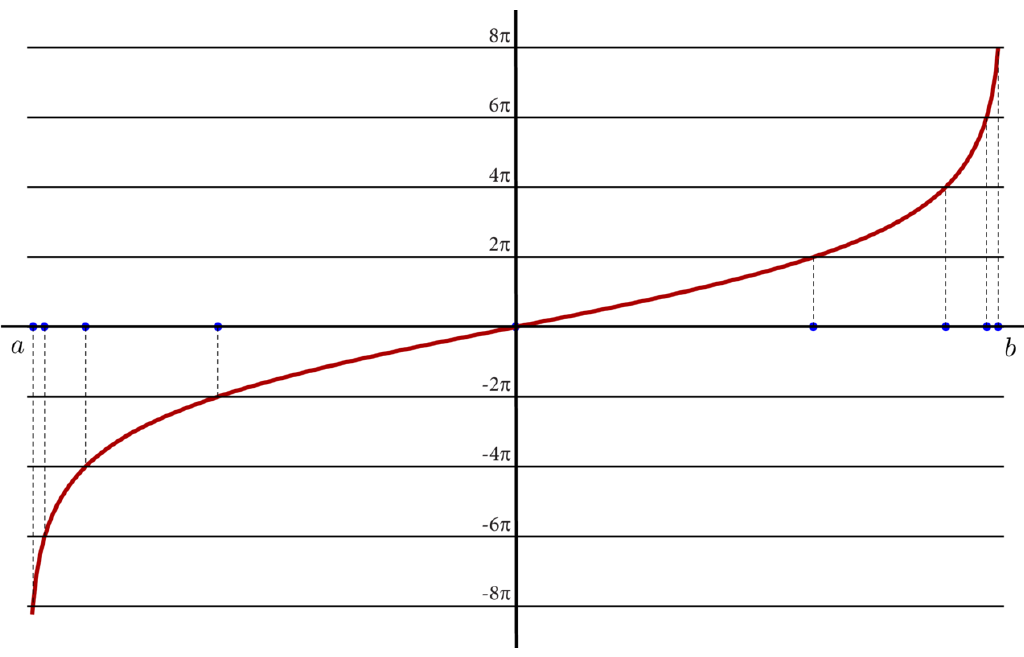
JHEP09(2019)076